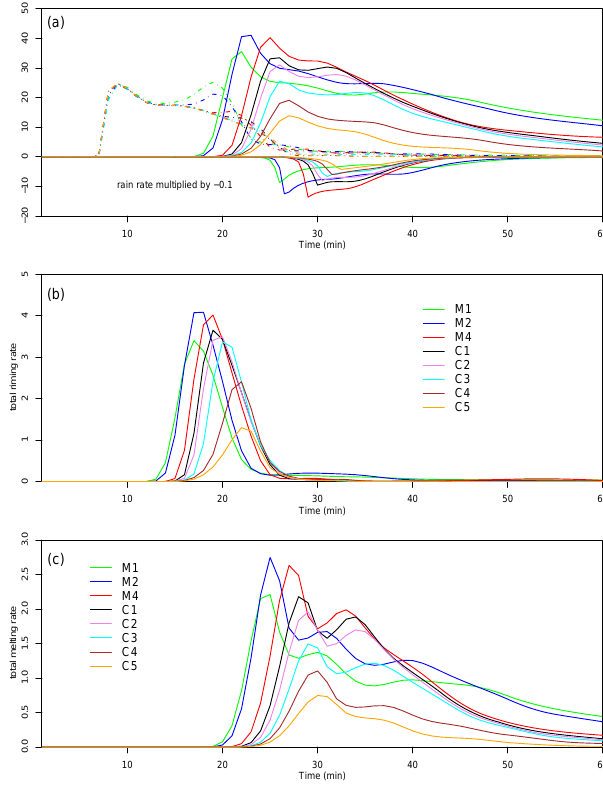
Fig. 11. New Mexico clouds: (a) The sum of drop mass (gkg − 1 in dash-dotted lines), graupel mass (gkg − 1 in solid lines) at the level just above 0 ◦ C. The precipitation rate in Fig. 4 is also added in the figure for reference. Note that the precipitation rate is multiplied by − 0.1 to avoid congestion in the figure. Temporal variation of total riming rate (b) and total melting rate (c) from NM-v2 cases. The units are gkg − 1 s − 1